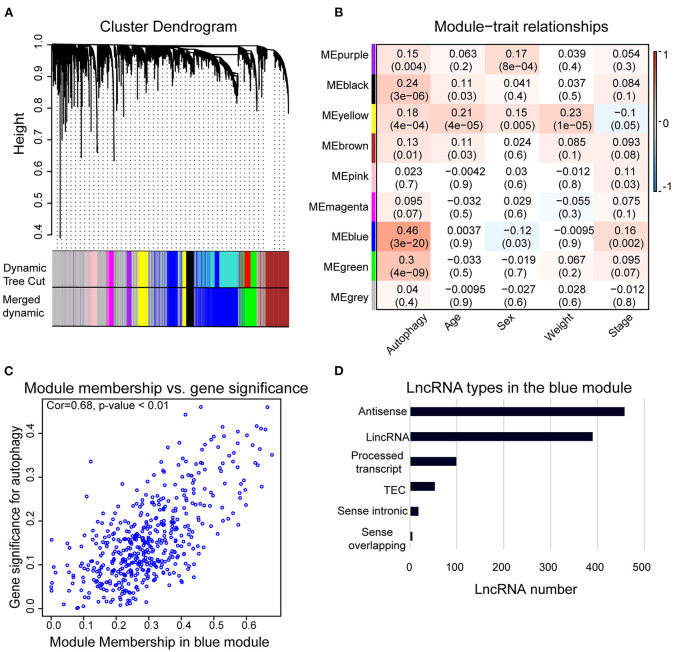
Weighted correlation network analysis (WGCNA) of lncRNAs in hepatocellular carcinoma (HCC) samples. (A) Gene clustering tree (dendrogram) obtained by hierarchical clustering of adjacency-based dissimilarity. (B) Module–trait relationships. Each row corresponds to a module of eigengenes, and each column corresponds to a clinical feature, respectively. Each cell contains the corresponding value of correlation in the first line and p-value in the second line, respectively. The cell color presents the correlation according to the color legend. (C) Correlation between membership in the blue module and membership in the autophagy pathway of the eigengenes in blue module by Pearson correlation analysis. Cor, correlation coefficient. (D) Bar chart shows the types of lncRNAs in the blue module.